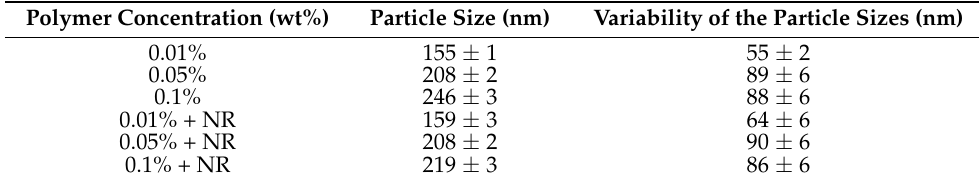
Table 6. Particle sizes of dispersions prepared with or without Nile red (Y-mixer).